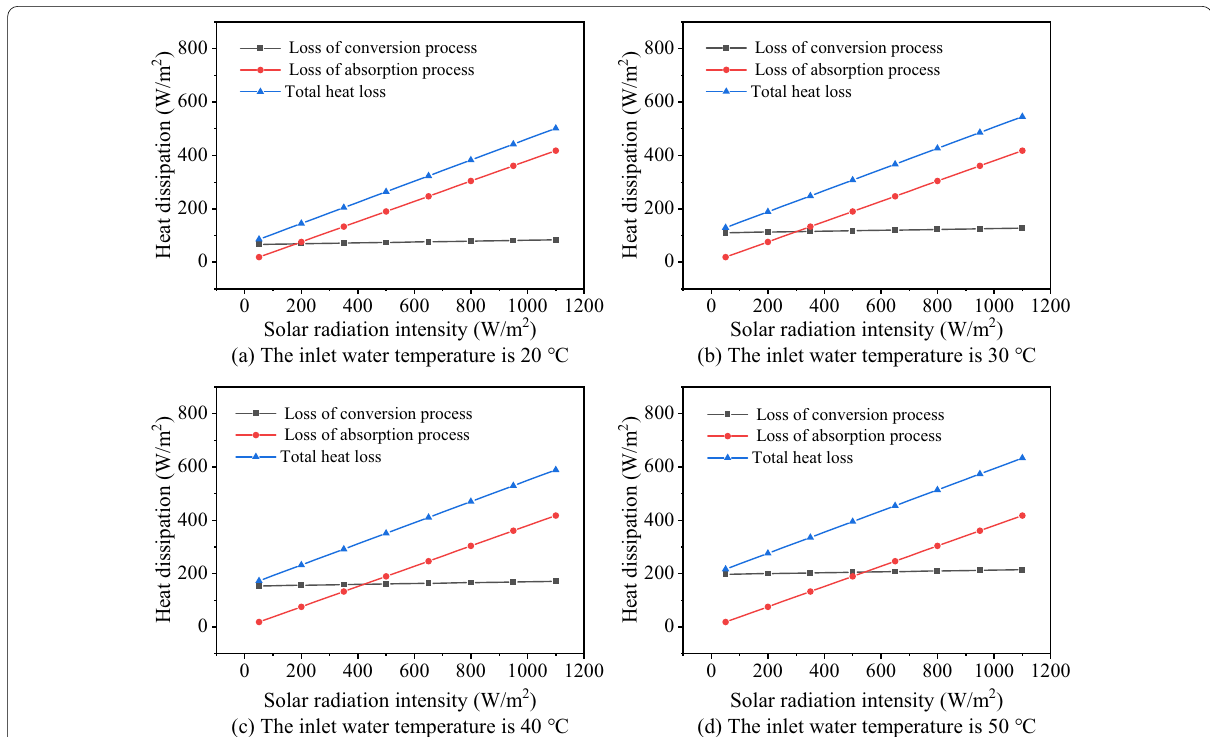
Fig. 10 Relationship between solar radiation intensity and heat loss of